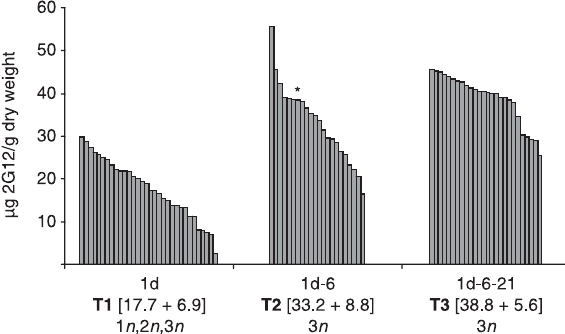
Figure 4 Antibody expression over three HiII generations. T 1 generation contains homozygous and hemizygous seeds (1 n –3 n in the triploid endosperm). The subsequent generations contain only homozygous seeds (3 n ). The T 2 plant used for the generation of T 3 seeds is indicated by an